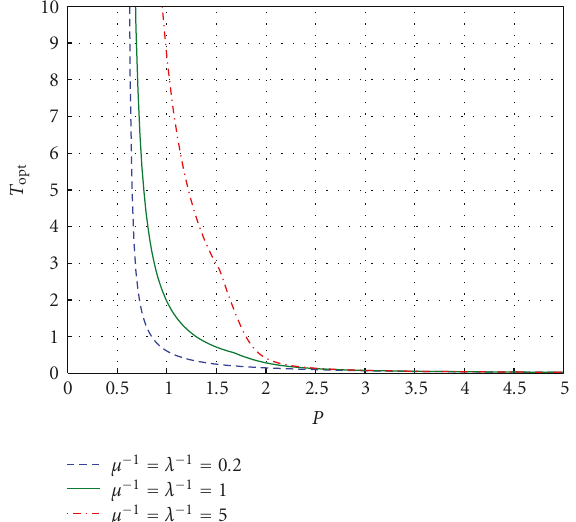
Figure 13: The optimal T opt under policy π 2 for di ff erent C.